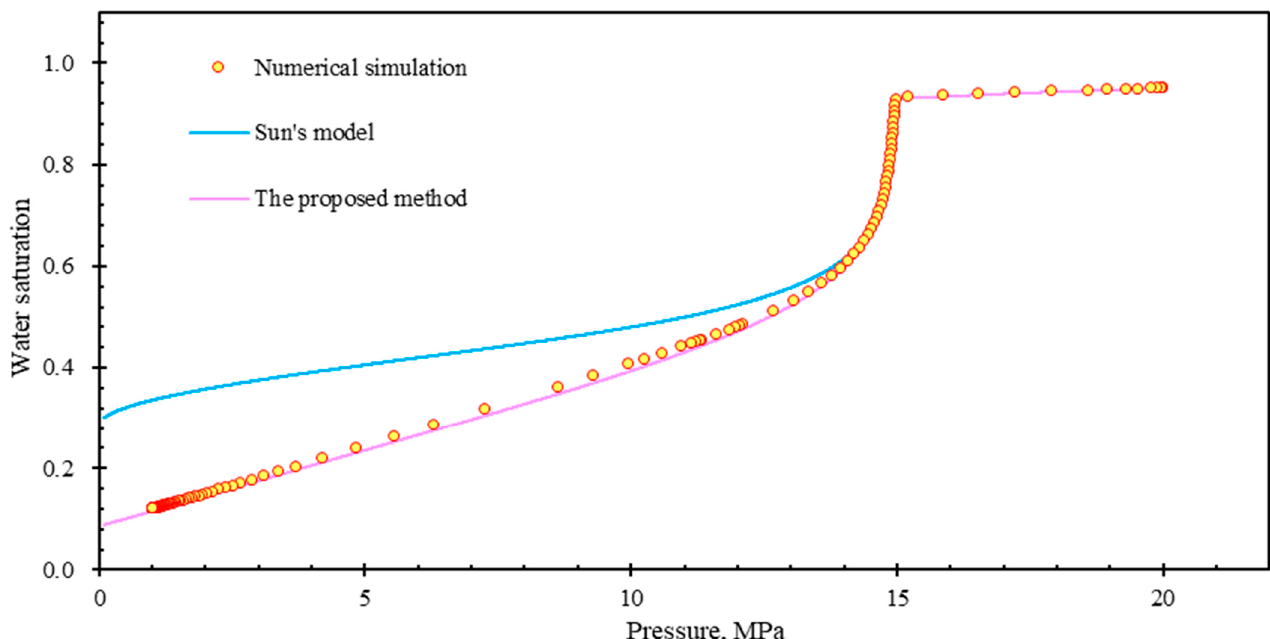
Figure 4. Comparison results of the proposed method with the numerical simulation method and Sun’s method.